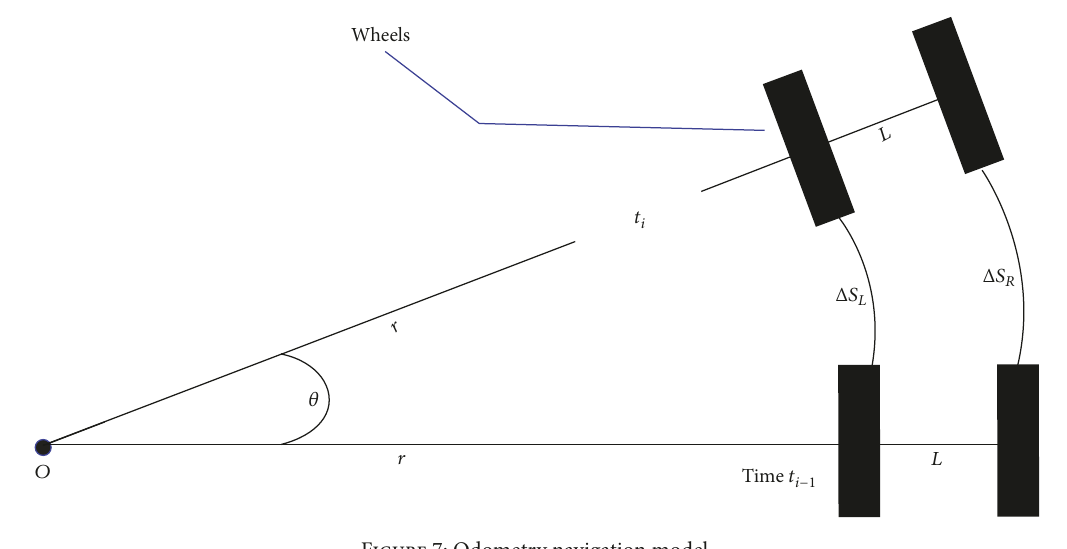
Figure 7: Odometry navigation